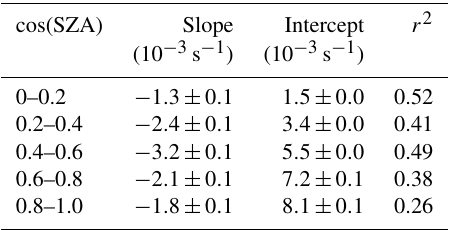
Table 4. Slope, intercept, and the square of correlation coefficient ( r 2 ) of linear fits of correlation between j (NO 2 ) and AOD for each ozone column class at AOD smaller than